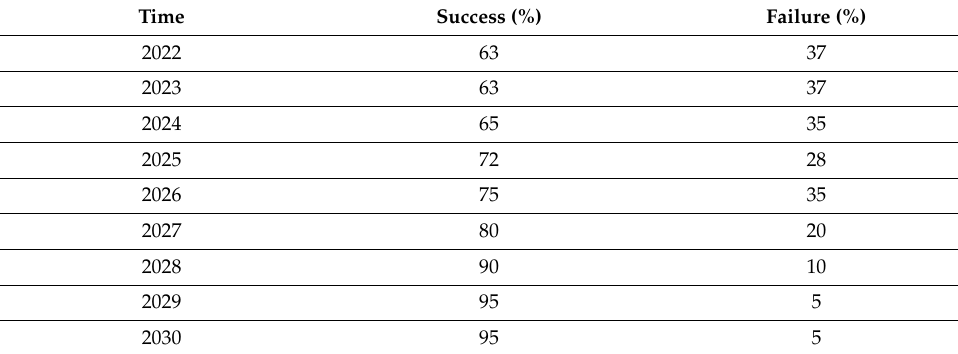
Table 6. The updated probability of